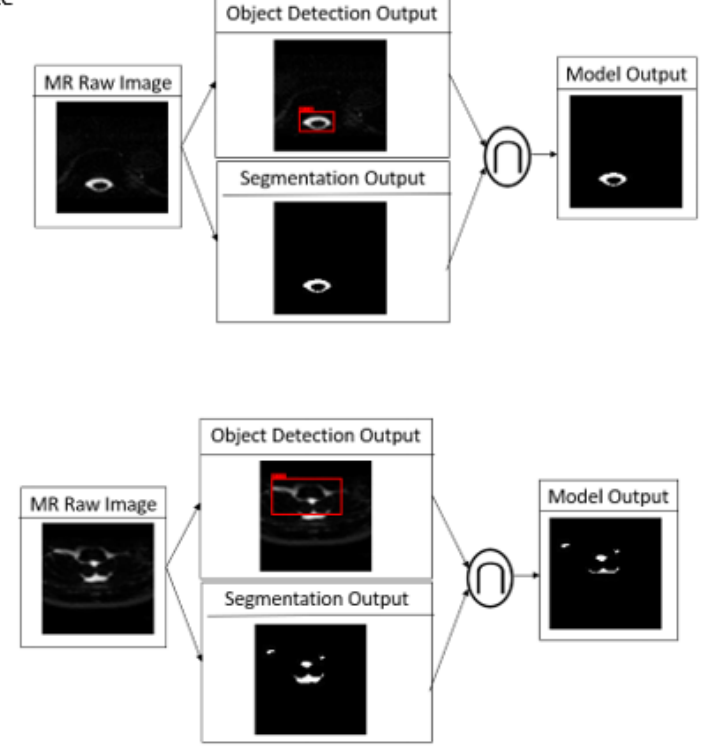
Figure 3. Successful ( a ) and failed ( b ) examples of the proposed cascade model. The results show that the performance from cascade of U-net++ and YOLO v3, from cascade of U-net and YOLO v3, from U-net++, and from U-net on average were 0.9374, 0.9373, 0.9102, and 0.9077, respectively. Single-tailed paired t -tests were conducted to